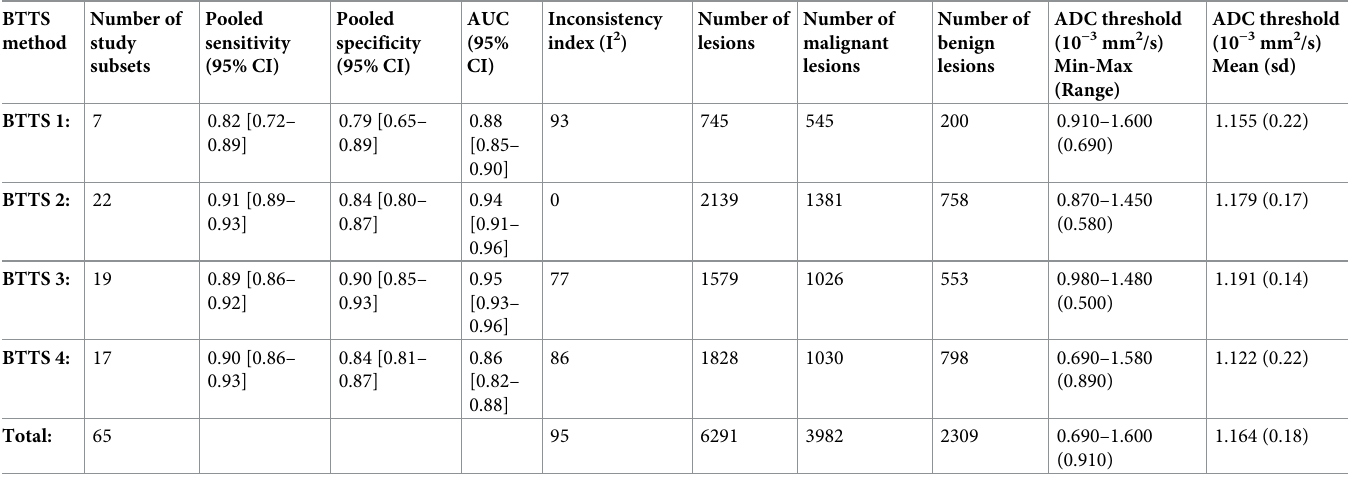
Table 2. Pooled data categorized per BTTS method, including heterogeneity